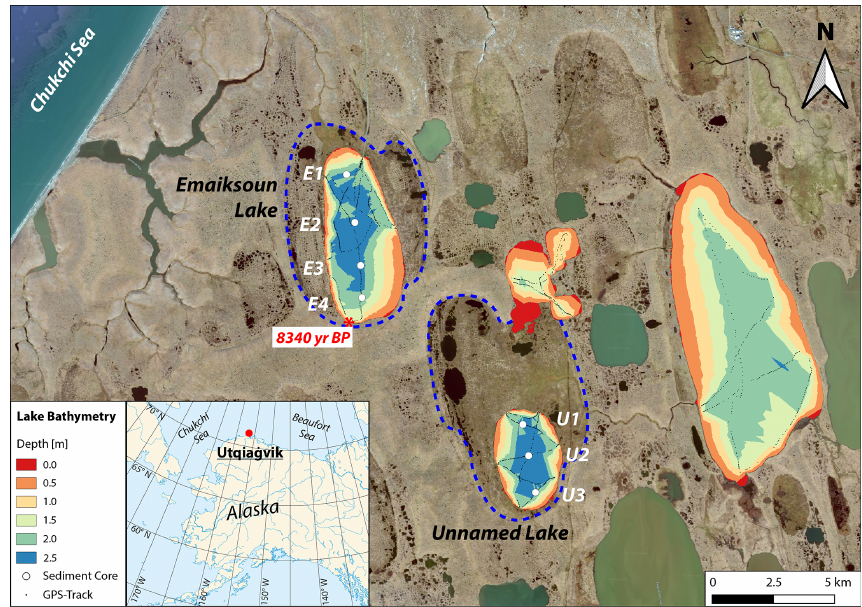
Figure 1. Study area 5km south of Utqia˙gvik (Alaska) with lake bathymetry maps. Emaiksoun and Unnamed Lake were sampled for sediment core transects E1–E4 and U1–U3, respectively. Dashed blue outlines indicate their remnant shorelines of previous lake extents (or old partially drained lake basins). The location and age of a radiocarbon shoreline sample is displayed at the southern shoreline of Emaiksoun Lake. (The overview map was created with the Generic Mapping Tool 6.1.1. The main map was created in QGIS 3.16.0 with the OpenLayers Plugin through imported satellite images from © Google Maps (map data: 2020